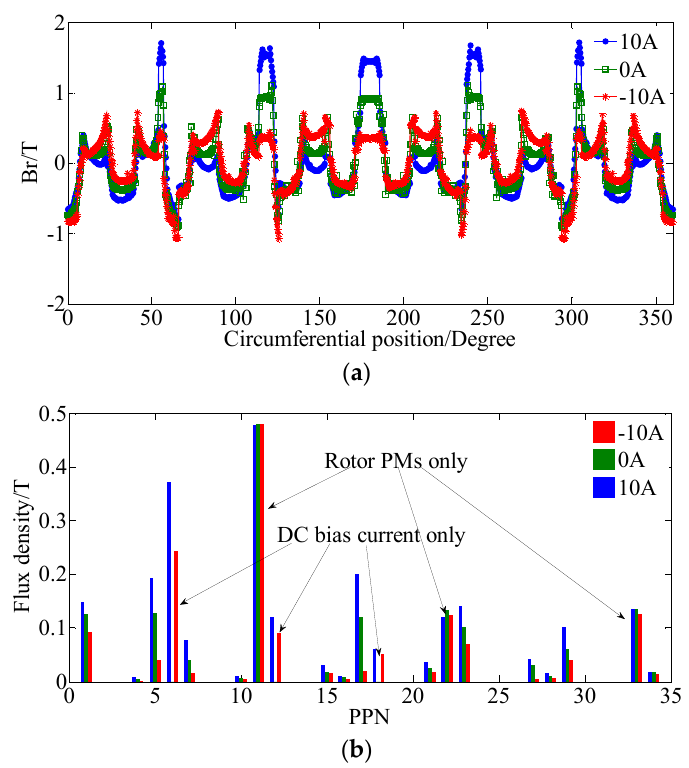
Figure 7. No-load air-gap flux density distributions and harmonics. ( a ) Flux density distributions. ( b ) Harmonics.